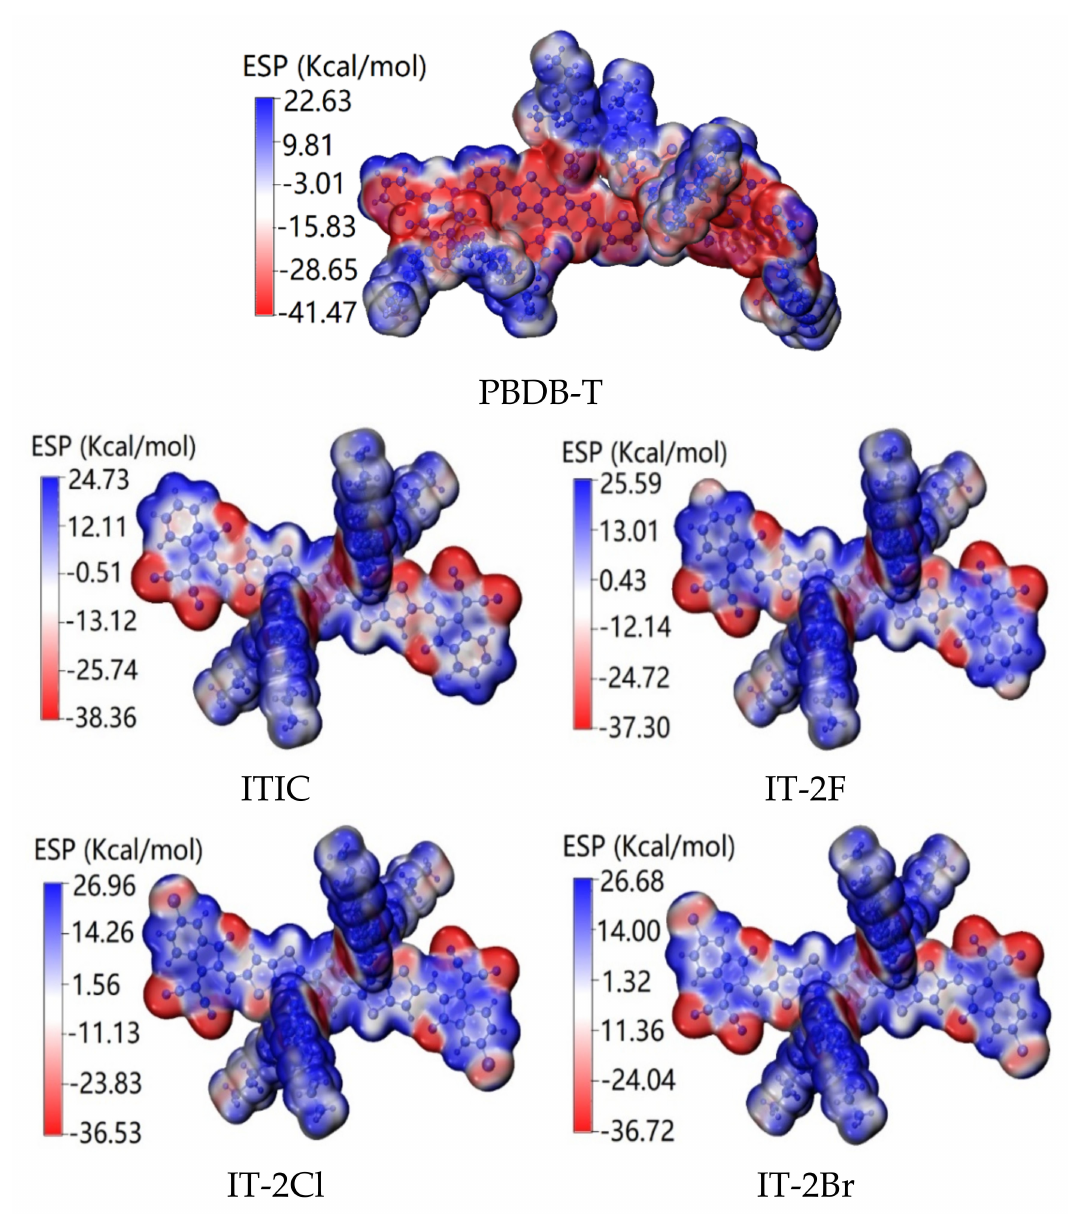
Figure 4. Electrostatic potentials (ESP) distributions of ITIC, IT-2X (X = F, Cl, Br) and PBDB-T molecules. The red (blue) color represents the low (high) potential areas. (LC-PBE/6-31G(d,p); α = 0.200, β = 0.086; ε s = 3.5, ε d = 3.3; ω = 0.155, 0.155, 0.167, 0.144, 0.155 Bohr − 1